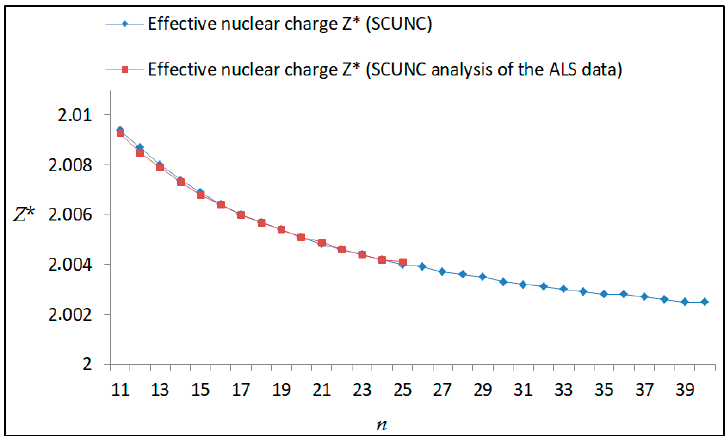
Figure 18. Variations of the effective nuclear charge Z* with the principal quantum number n for the 4 s 2 4 p 2 ( 1 D 2 ) ns Rydberg series originating from 2 D ° 3/2 metastable state of Se + converging to the 3 P 2 series limits in Se 2+ . Table 10. Energy resonances ( E ), quantum defect ( δ ) and effective charge ( Z *) of the 4 s 2 4 p 2 ( 1 D 2 ) ns ( 2 D ) Rydberg series originating from the 4 s 2 4 p 3 2 D° 5/2 metastable state of Se + converging to the 1 D 2 series limit in Se 2+ . The present results (SCUNC) are compared with the experimental data from ALS measurements [6]. The uncertainties in the experimental energies are stated to be ±0.010 eV, f 1 ( 1 D 2 ; 2 D° 5/2 ) = − 0.927 ± 0.050 with ν = 7. Initial Se + State: 4 s 2 4 p 3 2 D° 5/2 SCUNC ALS n